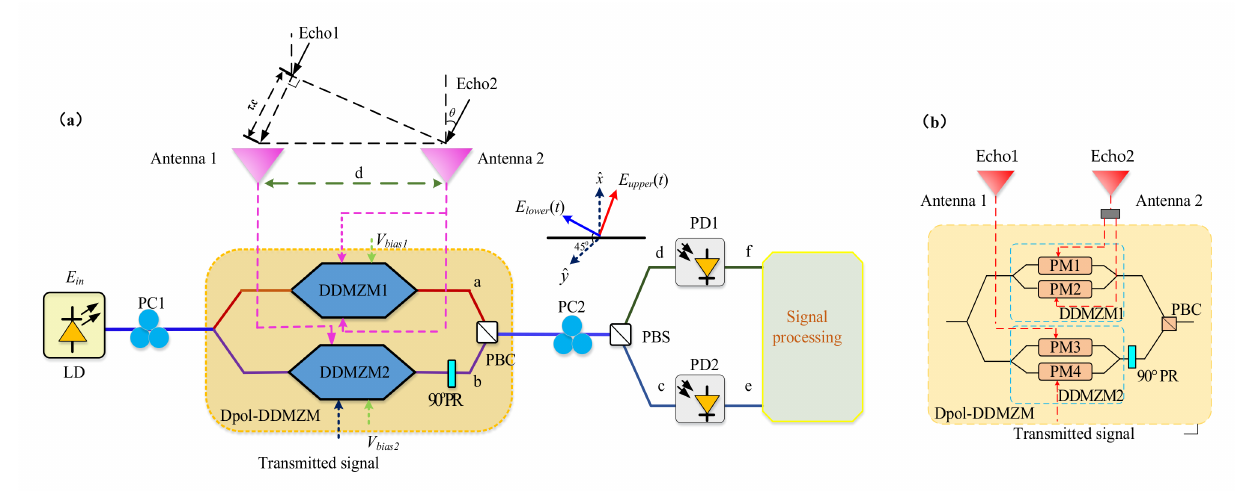
Figure 1. ( a ) Schematic diagram of the proposed AOA and DFS measurement system. LD: laser diode; DPol-DDMZM: dual-polarization dual-drive Mach–Zehnder modulator; PC: polarization controller; 90 ◦ PR: 90 ◦ polarization rotator; PBC: polarization beam combiner; PBS: polarization beam splitter; PD: photodetector. ( b ) The layout of